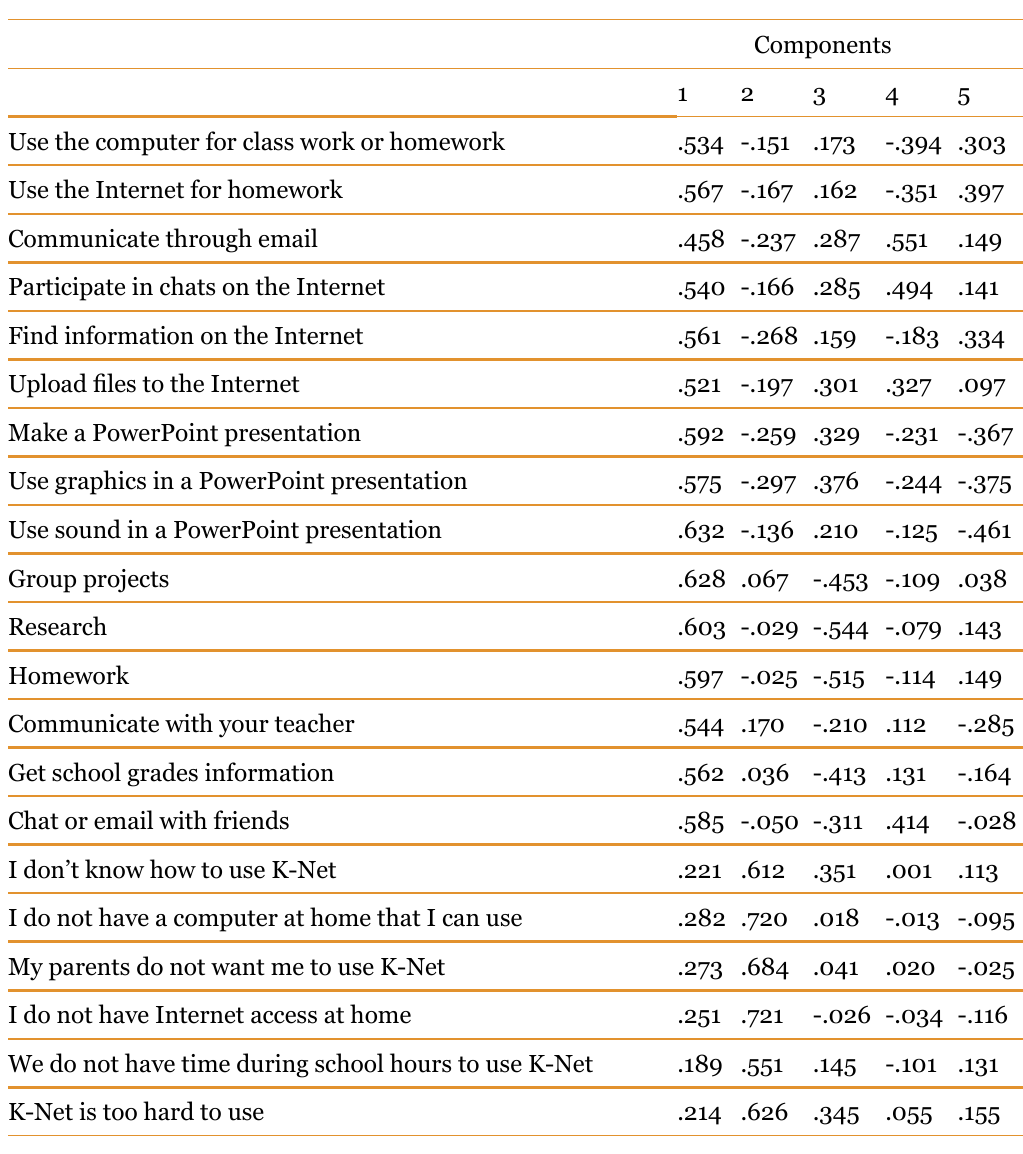
Principal Component